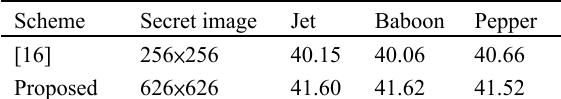
Table 2. Comparison about PSNRs of stego-image and the size of secret image.